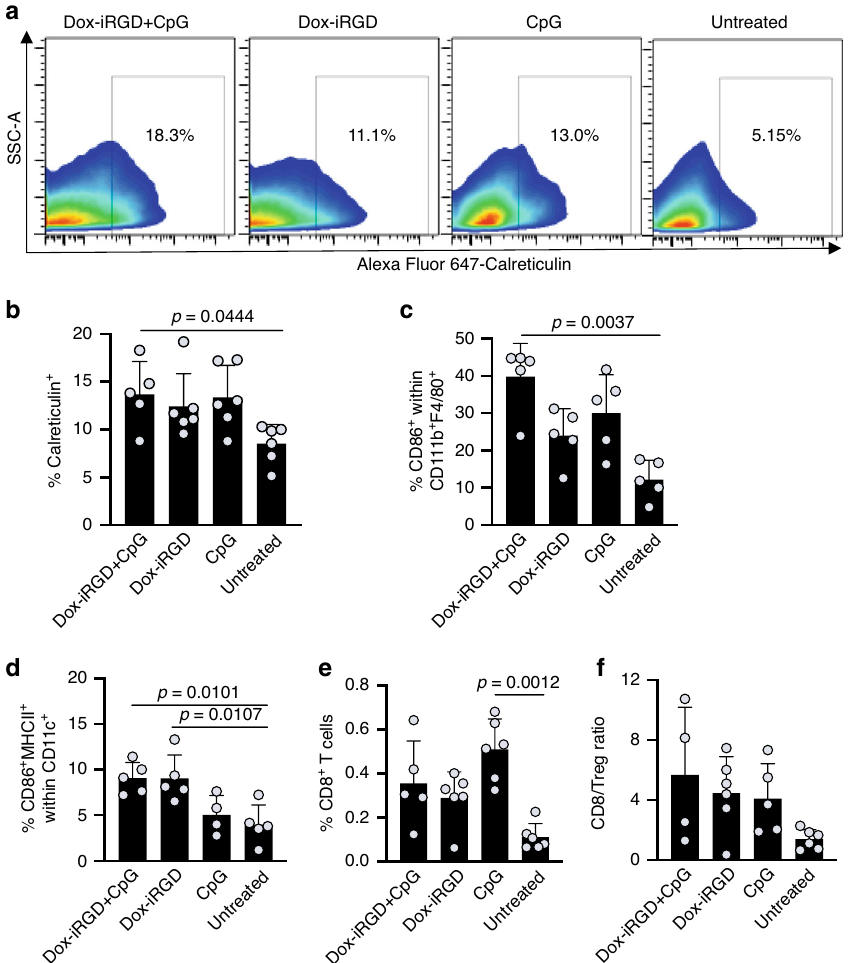
Fig. 5 Pore-forming gels loaded with GM-CSF, Dox-iRGD, and CpG induce immunogenic death of tumor cells, in fl ame tumor microenvironment, and increase effector T-cell in fi ltration. Following 4T1 tumor inoculation on day 0, gels containing Dox-iRGD (200 μ g) and CpG (100 μ g), or Dox-iRGD (200 μ g) alone or CpG (100 μ g) alone were injected peritumorally on day 5. Tumors were analyzed on day 16. a Representative FACS plots of tumor cells stained for the immunogenic death marker, calreticulin. CD11b + , CD3 + , and CD8 + cells were excluded for these plots. b Percentage of calreticulin + tumor cells in different groups. c Percentage of CD86 + cells among CD11b + F4/80 + tumor-associated macrophages. d Percentage of CD86 + MHCII + cells among CD11c + DCs in tumors. e Intratumoral in fi ltration of CD8 + T cells in different groups. f Ratio of CD8 + to regulatory T cells in tumors. For b – f , data are presented as mean ± SD; n = 6 biologically independent animals per group. Statistical analysis was performed using ANOVA with Fisher ’ s LSD post hoc test. Source data are provided as a Source Data